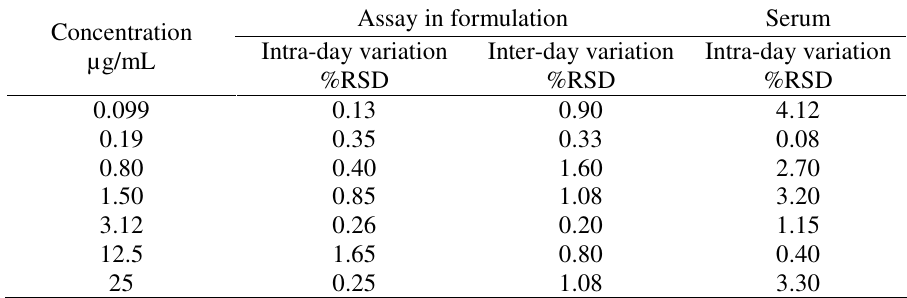
Table 2. Intermediate precision of the